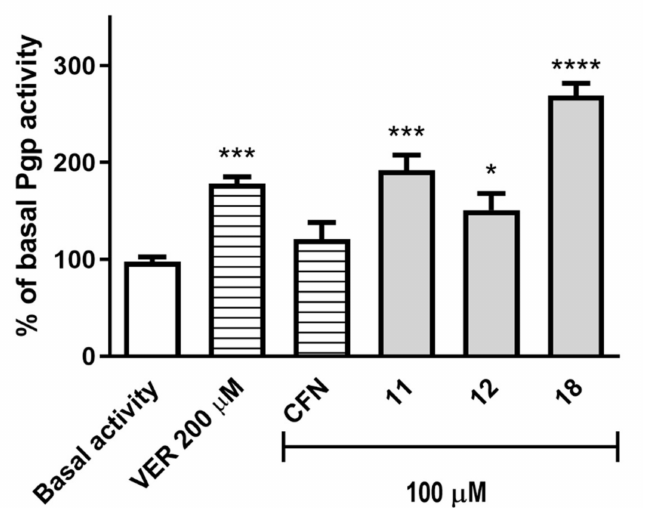
Figure 3. The e ff ect of the ABCB1 substrate verapamil (VER) (200 µ M), ABCB1-negative compound ca ff eine (CFN), and compounds 11 , 12 , and 18 (100 µ M) on ABCB1 basal activity. The compounds are recognized as ABCB1 substrates if they stimulate its basal activity ( > 100%). Data are presented as the mean ± SD. Statistical significance was evaluated by one-way ANOVA, followed by Bonferroni’s comparison test (* p < 0.05, *** p < 0.001, **** p < 0.0001 compared to the basal